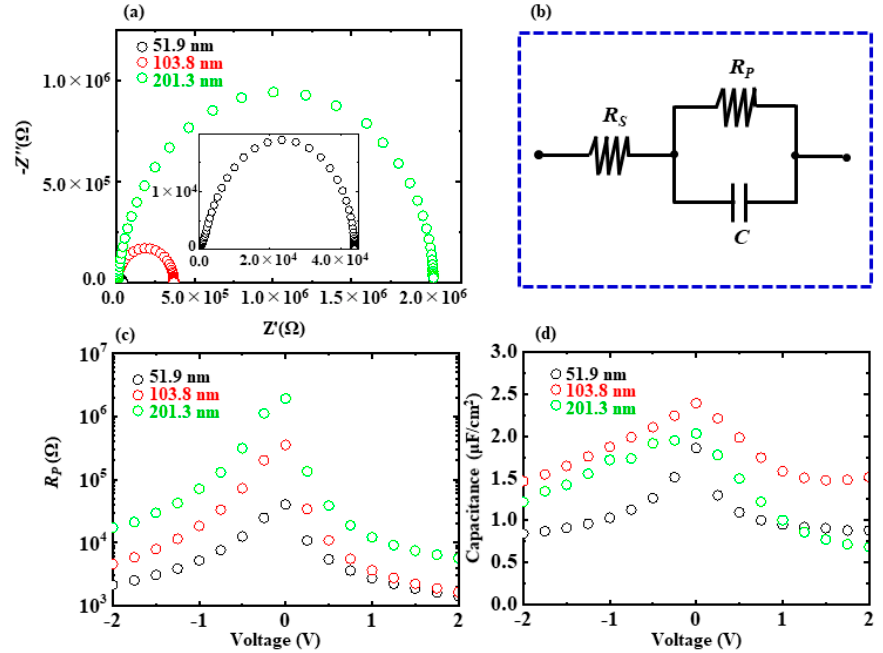
Figure 7. ( a ) Impedance spectra of the Si/Ti/Pt/ATO NL/Ti/Au capacitors measured at 0 V in the frequency from 1 Hz to 1 MHz. The sublayer thicknesses for them are the same at 0.51A/0.52T. The total thicknesses for the ATO NL layers are 51.9 (black circle), 103.8 (red circle), and 201.3 nm (green circle). ( b ) Equivalent circuit for the Si/Ti/Pt/ATO NL/Ti/Au capacitors. ( c , d ) R p and capacitance as functions of voltage derived from the impedance spectra, respectively.